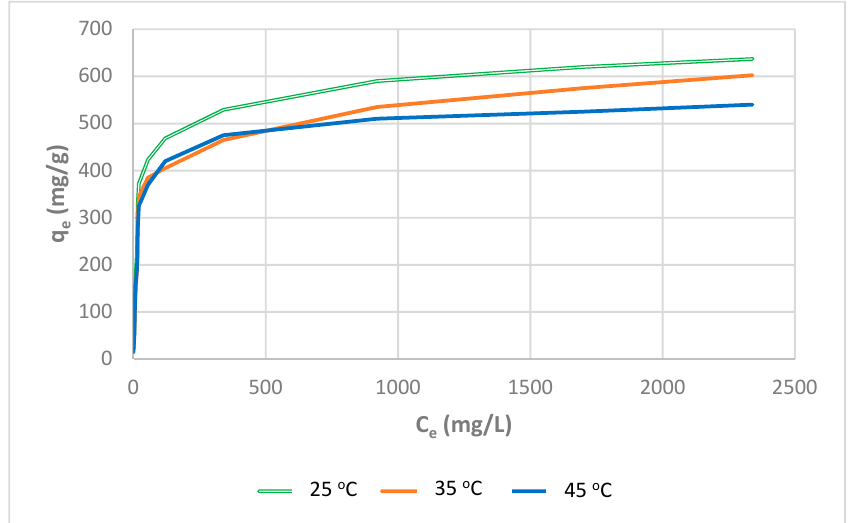
Figure 19. Experimental adsorption isotherms of Direct Yellow RL for WBR achieved at various temperatures (conditions: phase contact time: 180 min, volume: 20 mL, resin mass: 200 mg, agitation rate: 180 rpm).